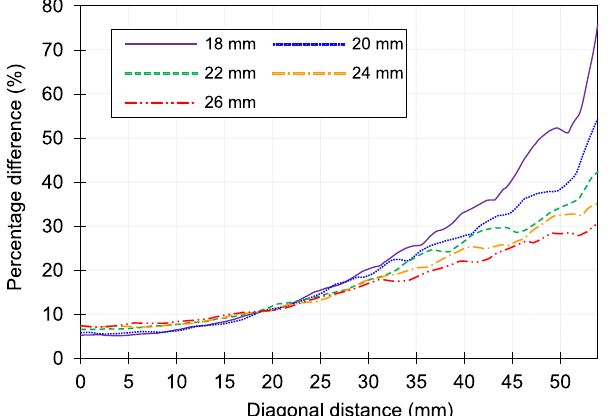
Figure 3. Percentage differences of the magnetic flux density z-component B z between square and cylindrical coils along the diagonal distance from center to corner at different